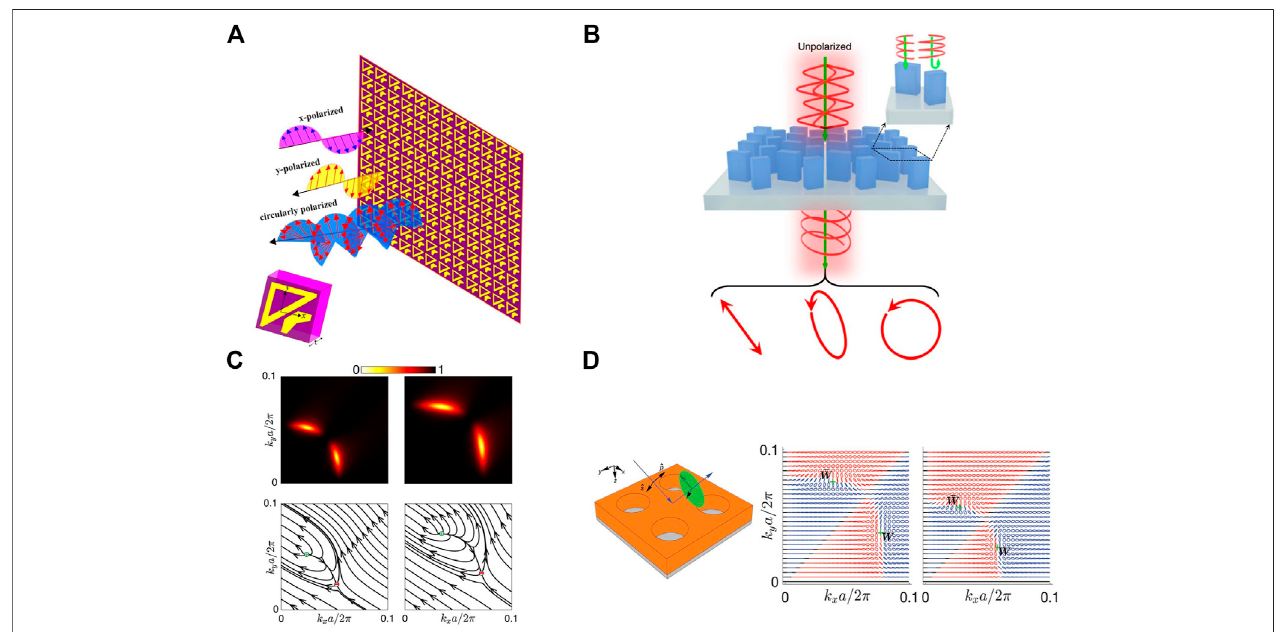
FIGURE7 |(A) fi sh-like metasurface converting linear polarization to orthogonal-linearand circular polarization [142], copyright Springer Nature Ltd. (B) Dimerized nanopillars generating linear, ellipticaland circular polarization regardless ofinputpolarization [145],copyright Springer Nature Ltd. (C) Maps ofre fl ection coef fi cient and vector fi eld of re fl ection in momentum space in the polarization conversion [52], copyright American Physical Society. (D) PhC slab manipulating incident polarization to arbitrary polarization in re fl ection [146], copyright Wiley-VCH GmbH,